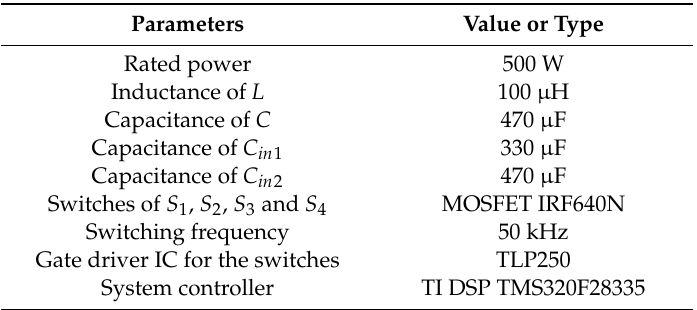
Table 1. Circuit specifications of the proposed bidirectional